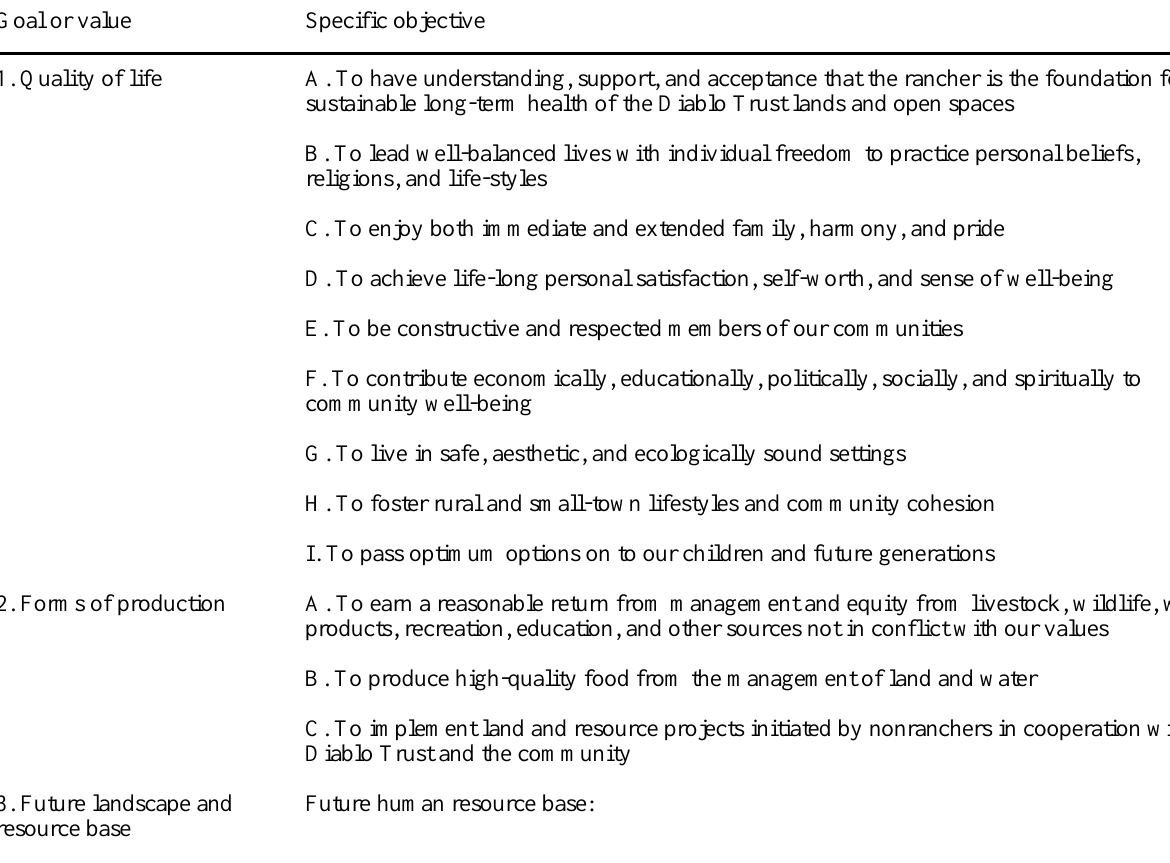
Table 2. Diablo Trust three-part holistic goal. Source: Diablo Trust (1999). Goal or